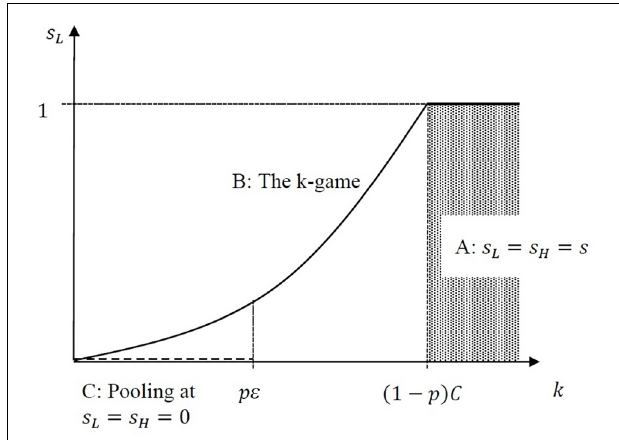
FIGURE 2 | Equilibria of the prestige game. Dashed line indicates pooling equilibria for very low values of k , and shaded area indicates that any pooling behavior can stand as an equilibrium if k is high